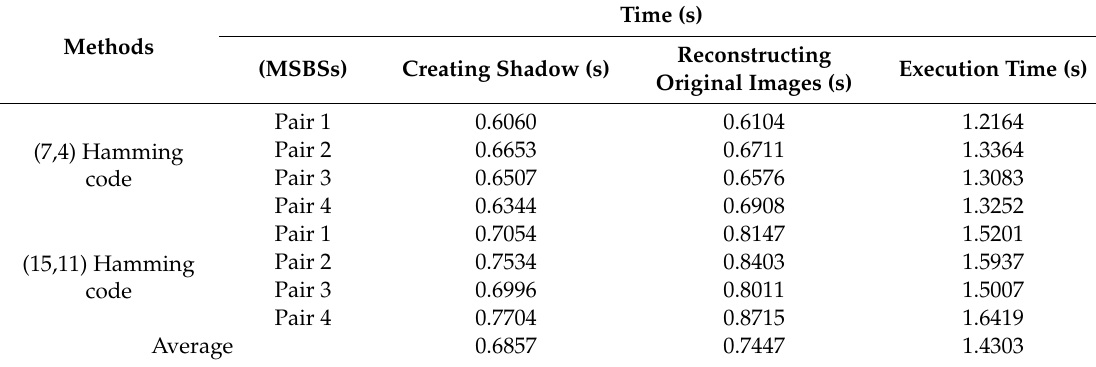
Table 4. Experimental results of execution time (s) for our proposed schemes.